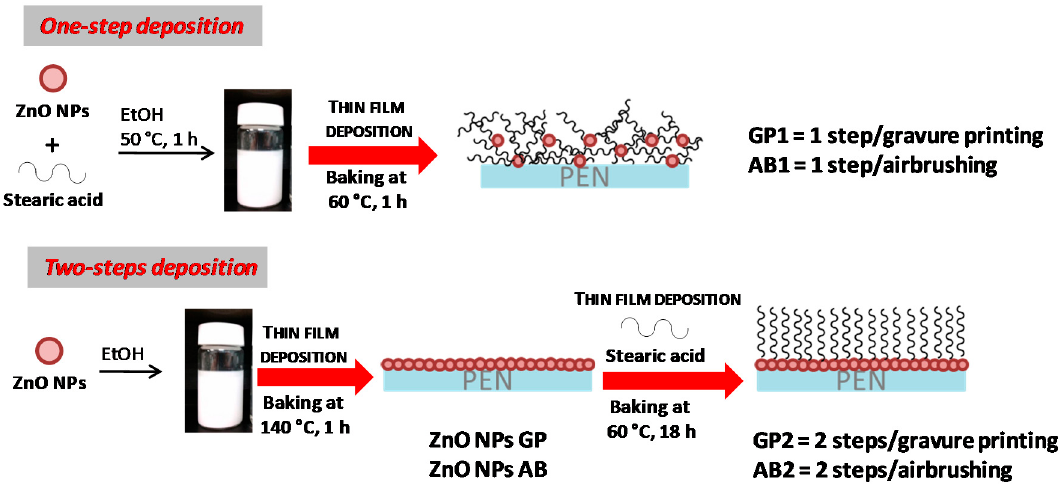
Figure 2. Procedures for the deposition of the zinc oxide nanoparticles (ZnONPs)/stearic acid coatings on polyethylene naphthalate (PEN).